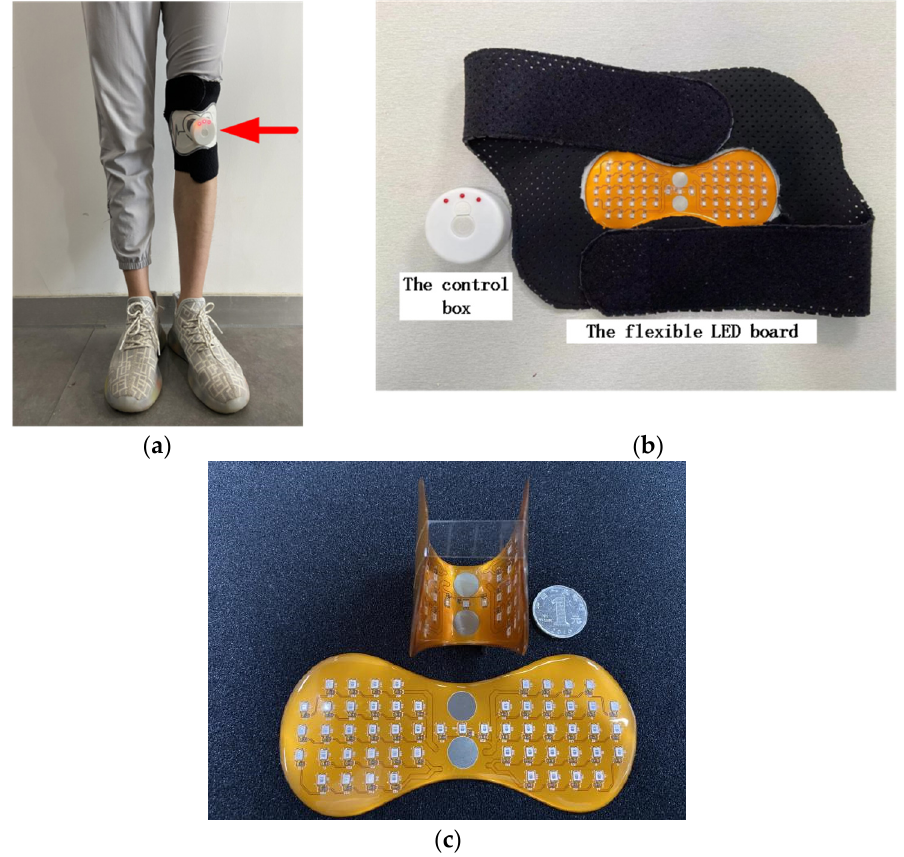
Figure 7. The wearable flexible phototherapy device for knee OA. ( a ) Photo of the device worn on a knee for osteoarthritis; ( b ) Physical photo of the device incorporating a flexible LED board and a control box; ( c ) Physical photo of the flexible LED board.